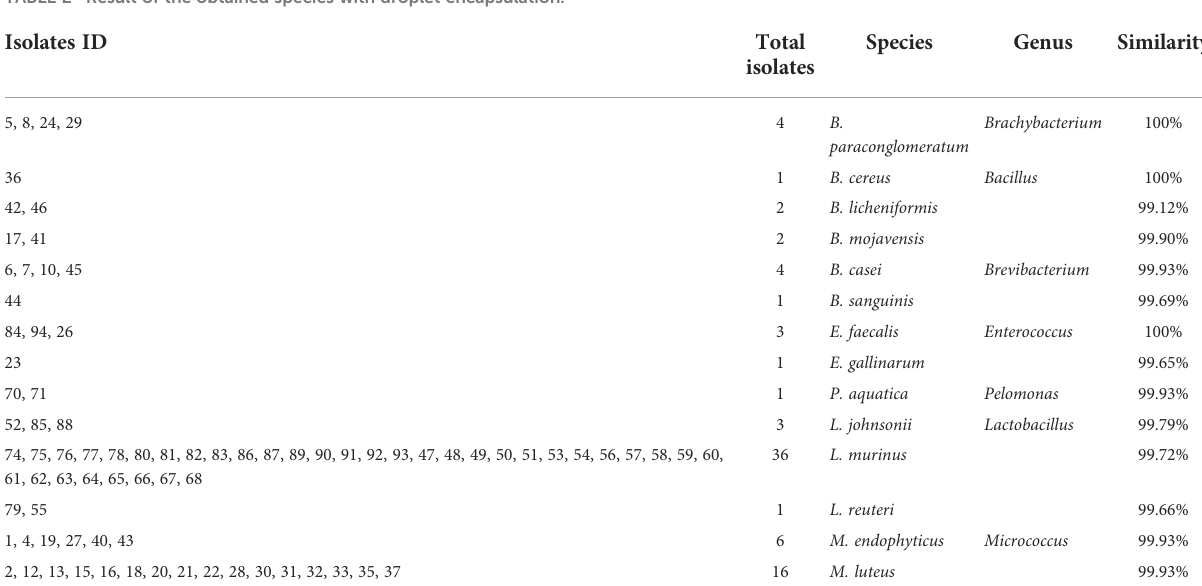
TABLE 2 Result of the obtained species with droplet encapsulation.